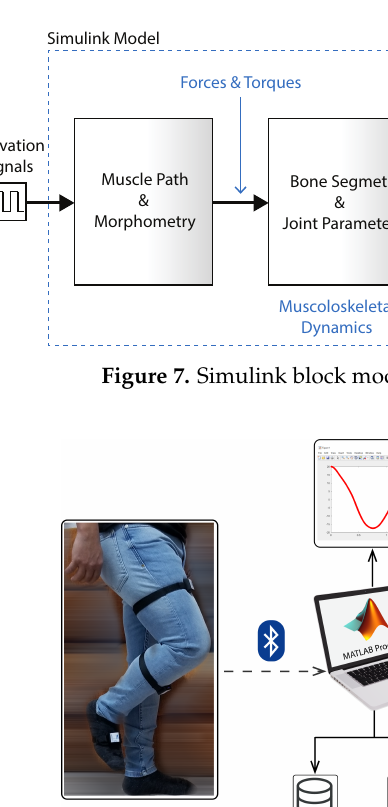
Figure 6. Musculoskeletal model of the lower limb. ( a ) Full model with the 44 Hill-type muscle tendon units. ( b ) Example of two wrapping objects to constrain the muscle–tendon path. ( c ) Ligaments of the right knee.